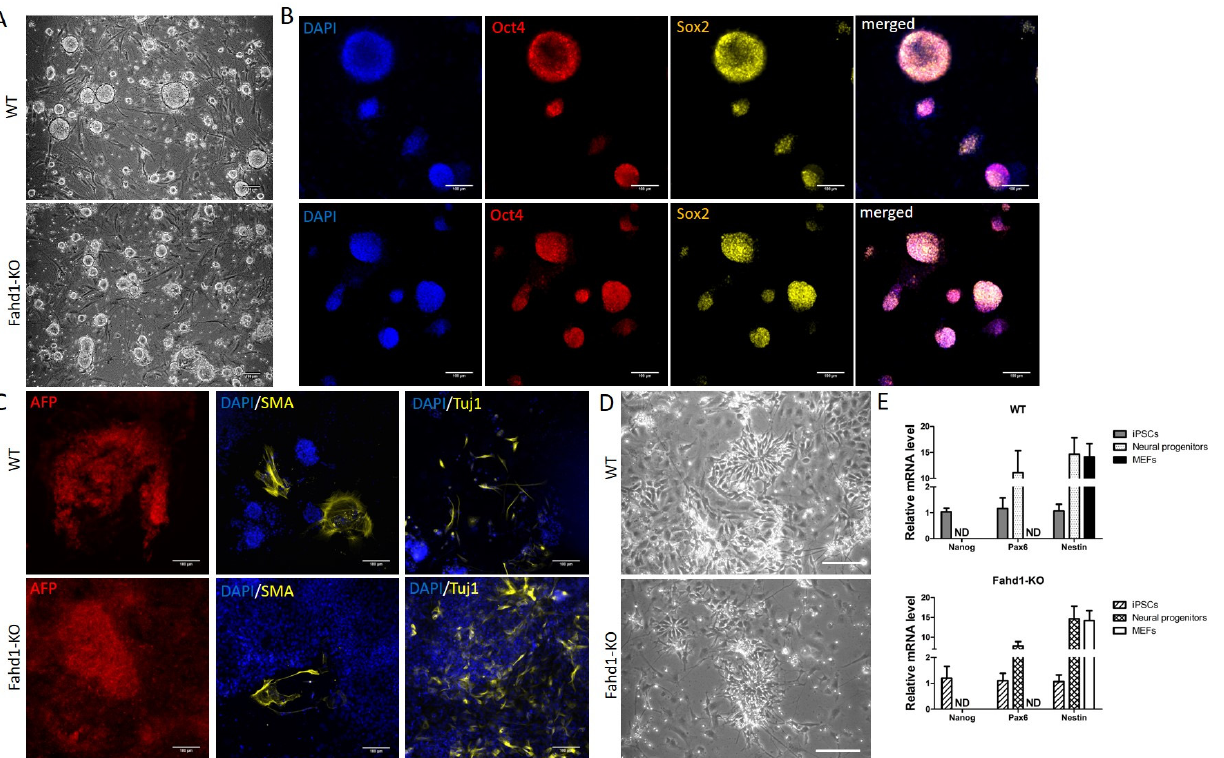
Figure 2. Germ layer and neural differentiation showed similar cell fate between WT and Fahd1-KO iPSCs. ( A ) Phase contrast imaging showing typical iPSC-like round colonies when cultured on inactivated MEFs. ( B ) Immunofluorescence showing the expression of the pluripotency markers Oct4 and Sox2 in both WT and KO iPSCs. Cell nuclei were stained with DAPI. ( C ) After germ layer differentiation, immunofluorescence on the differentiated cells showed the expression of the endodermal marker AFP, the mesodermal marker SMA, and the ectodermal marker Tuj1. ( D ) Neural differentiation showed typical neural rosette formation both in WT and Fahd1-KO, as it is shown in the phase contrast images. ( E ) Relative mRNA expression by qRT-PCR of the pluripotency marker Nanog, and the neural progenitor markers Pax6 and Nestin in WT and Fahd1-KO MEFs, iPSCs, and neural progenitors. The results showed a downregulation of the pluripotency and an upregulation of neural markers similarly in both WT and Fahd1-KO. MEFs: mouse embryonic fibroblasts, iPSCs: in-